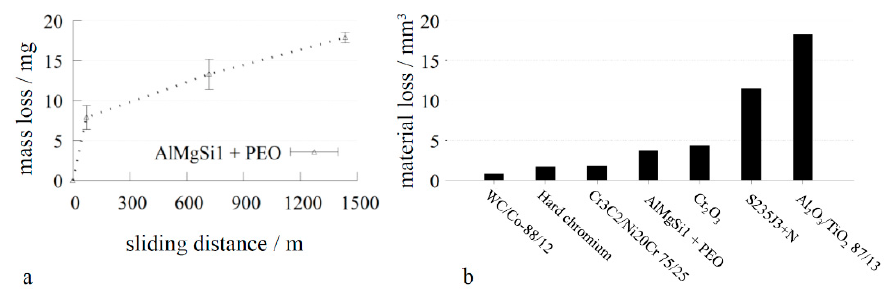
Figure 11. Wear performance of PEO coating on AlMgSi1 in the rubber wheel test: mass loss evolution in relation to the sliding distance ( a ), material loss after the testing in comparison with other coatings ( b ).